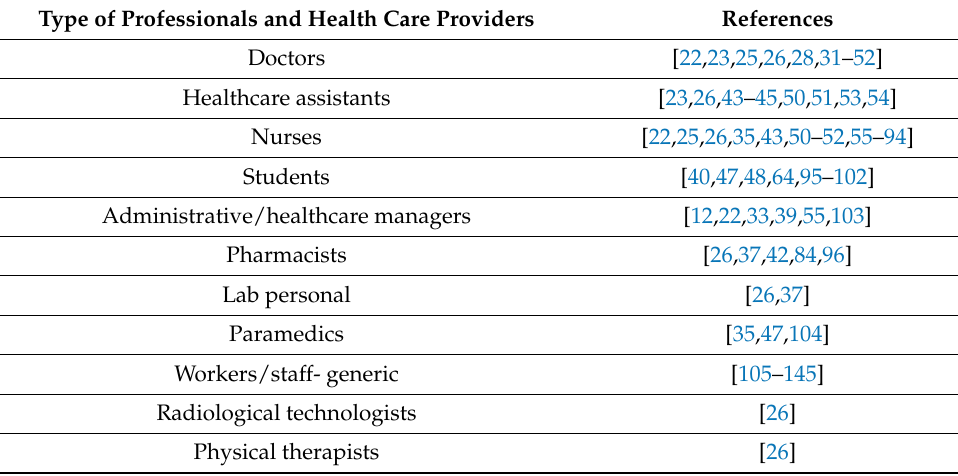
Table 5. Type of professionals and health care providers. Type of Professionals and Health Care